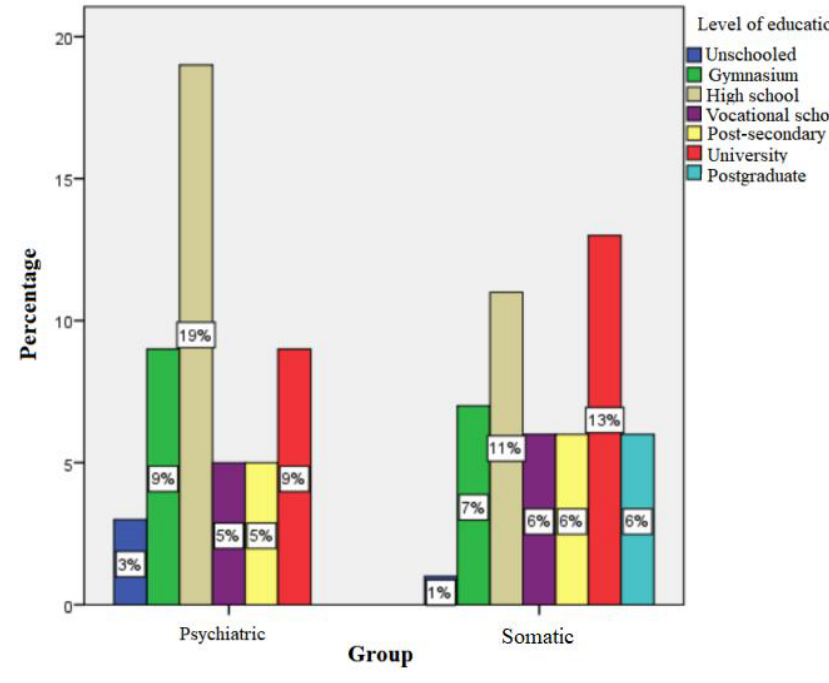
Figure 1. Level of school education of parents.